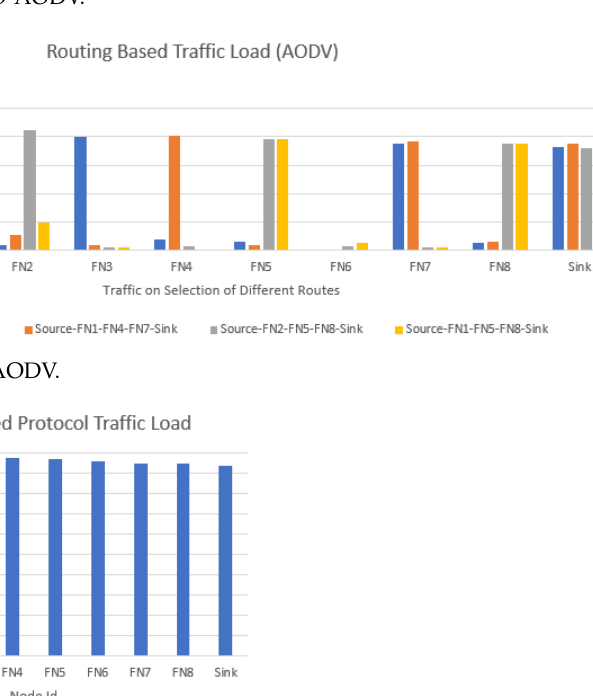
Figure 20. Traffic load: O-AODV.